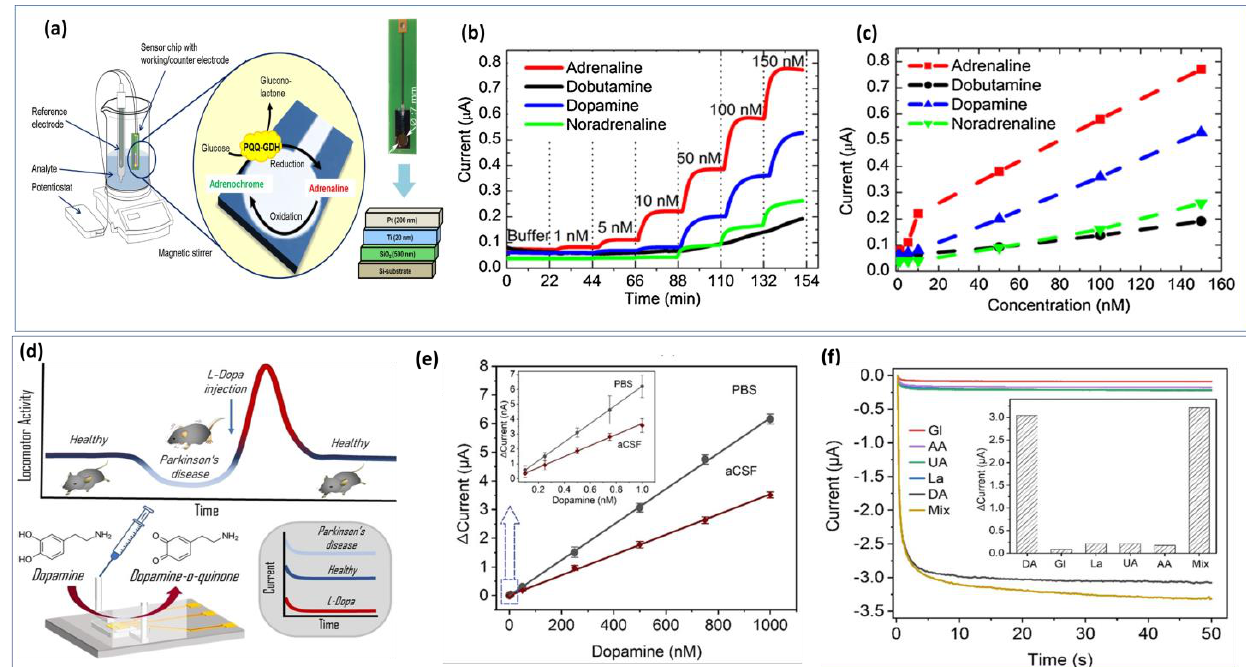
Figure 7. Portable on − chip based NTs biosensor: ( a ) Detection strategy based on bioelectrocatalytical amplification for selective adrenaline detection in human blood plasma. ( b ) Amperometric i − t curves of the biosensor measured in PBS with a variation of catecholamines in the concentration range of 1 nM to 150 nM. ( c ) calibration plots of the biosensor. Reproduced with permission from [162]. Copyright 2023, Elsevier. ( d ) Microfluidic channel based electrochemical detection of dopamine in mouse cerebrospinal fluid and blood. ( e ) Calibration graph performed in PBS or aSCF with an inset showing DA concentration up to 1 nM. ( f ) Selectivity studies of the DA biosensor in the presence of interferants, including glucose, lactate, uric acid, and ascorbic acid. Reproduced with permission from [163]. Copyright 2022, ACS.